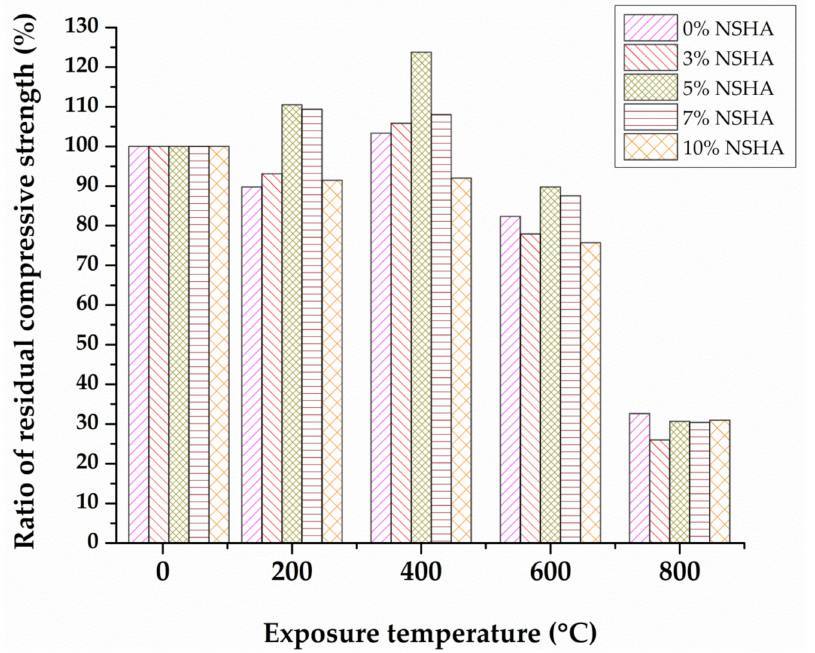
Figure 9. The ratio of residual compressive strength for the 28 days cured